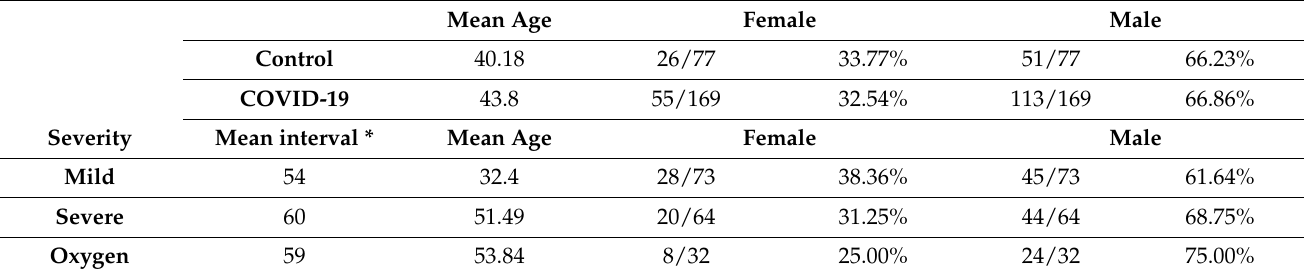
Table 3. Comparison of the demographic data across the groups. * Mean interval of days between symptom onset and sera sample